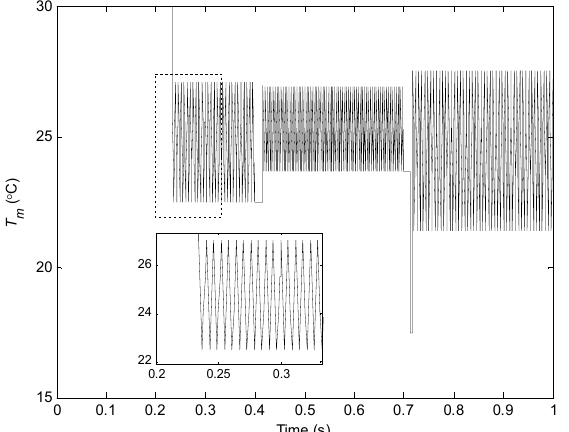
Figure 13. Curve in first simulation.